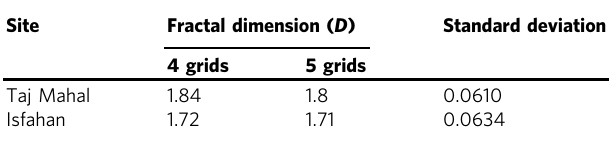
Table 2 Fractal dimensions